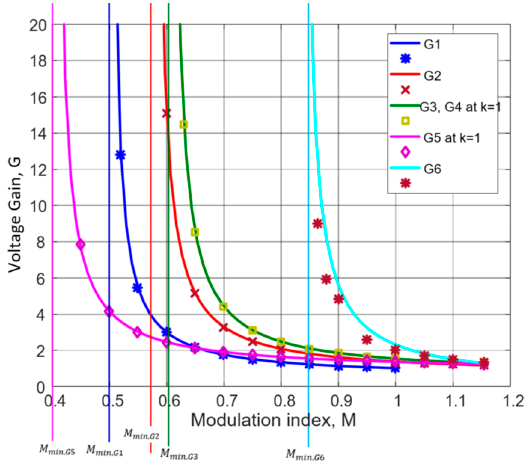
Figure 17. The relation between modulation index and voltage gain, solid lines: theoretical results, marks : simulation results.